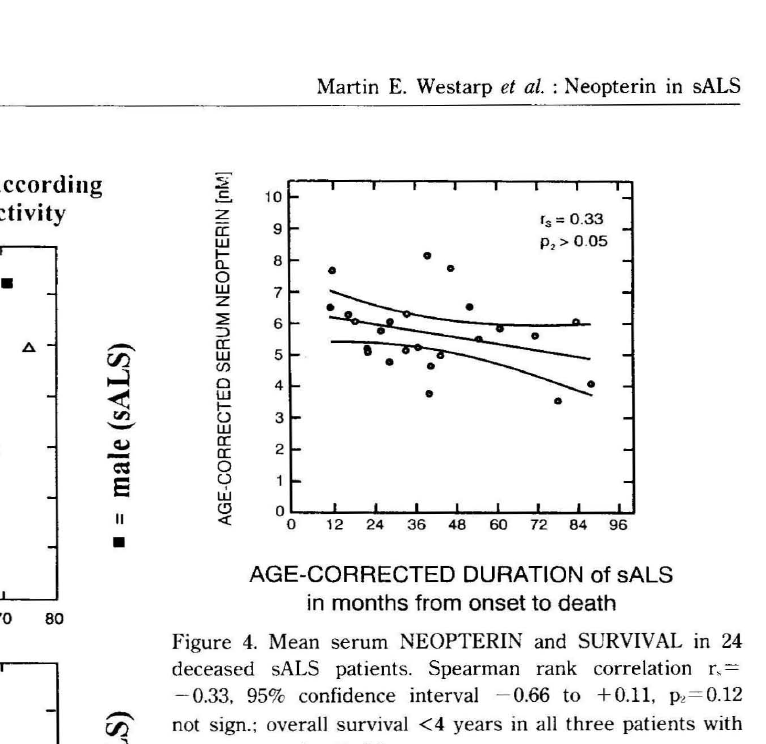
Figure 4. Mean serum NEOPTERIN and SURVIVAL in 24 deceased sALS patients. Spearman rank correlation L = - 0.33, 95% confidence interval - 0.66 to +0.11, p,= 0.12 not sign.; overall survival <4 years in all three patients with mean neopterin>7 nM. for f32-microglobulin plotted against these two time axes. Serum neopterin correlated well (rs=0.8, p< 0.001) with f32-microglobulin (Fig. 2). This correlation proved resistant to correction for age (rs = 0.74, p< 0.001). and led to a mean ratio of serum neopterin (nmoI!L) to serum f32-microglobulin (mg/L) of 3.97 ± 0.18 SE. Patient subgroups according to sympto matology, such as sALS with initially bulbar deficits (n = 5), did not exhibit different patterns of neopterin and f32-microglobulin. In twelve women and 18 men, we simultaneously examined neopterin, f32-microglo bulin and anti-human spuma retrovirus (HSRV) ser um antibodies by enzyme-linked immunosorbent as say (ELISA). Their neopterin serum concentrations did not distribute differently (Fig. 3). Corrected for age, serum neopterin and f32-micro globulin did not exceed 110% of upper reference limits even in generalized, tetra paretic and moribund patients. In 11 cases of sALS, cerebrospinal fluid neopterin ranged from < 3.0 (n = 3) to 6.0 nmol!L (n = 9). CSF neopterin from patients participating in a therapeutic trial with intrathecal interferon-1 aver aged 36.4 nmol/L. In unmedicated sALS all serum and cerebrospinal fluid (CSF, n= 11 patients) concen trations remained within reference limits, and serum neopterin regularly exceeded CSF neopterin. Approximated mean CSF concentrations did not differ from neurological controls: CSF neopterin (sALS): 3.2 nmol!L vs. 3.1 nmol/L (controls) CSF f32-microglobulin (sALS) : 1.2 mg/L vs. 1.3 mg! L (controls) CSF tryptophan: 2.1 mol/L vs. 1.8 Ilmol!L